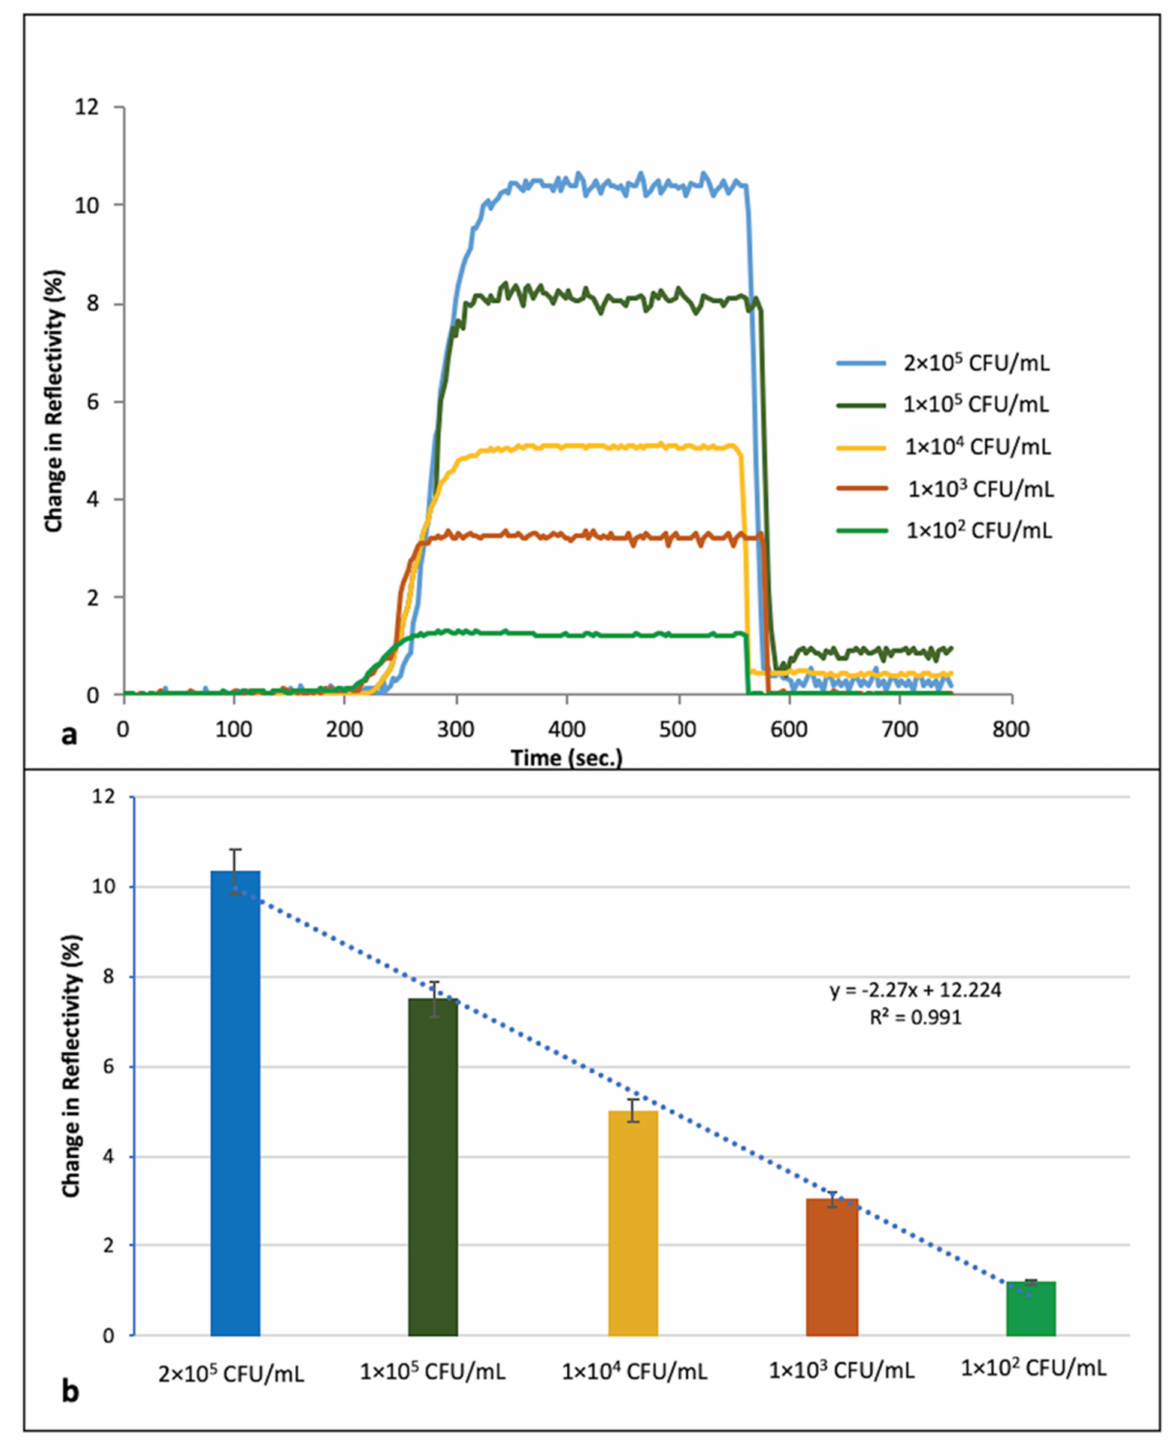
Figure 4. ( a ) Sensorgram of the S. aureus imprinted SPR sensor chips ( b ) Calibration curve of S. aureus obtained in a range of 1.0 × 10 2 –2.0 × 10 5 CFU/mL bacterial